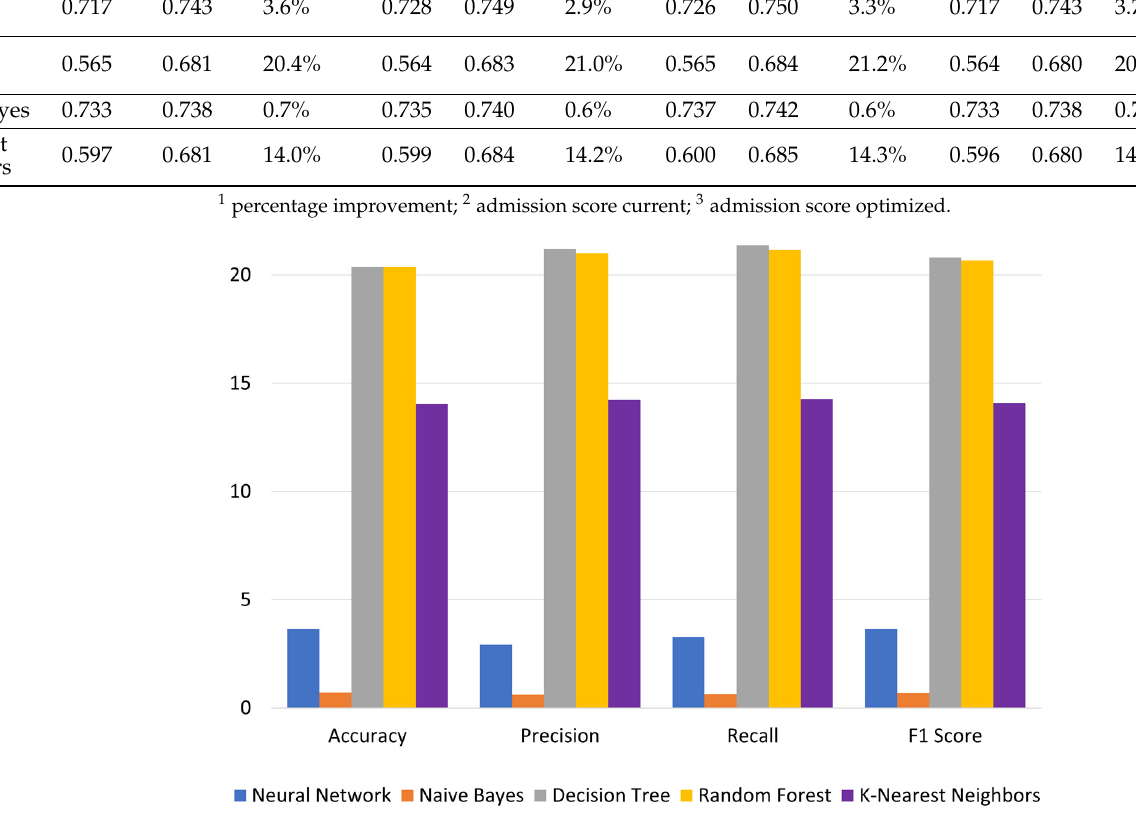
Figure 4. Percentage improvements in evaluation metrics for ASO models over ASC models.